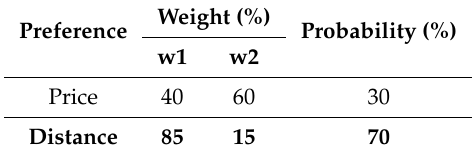
Table 6. Weights for the user distance preference scenario.